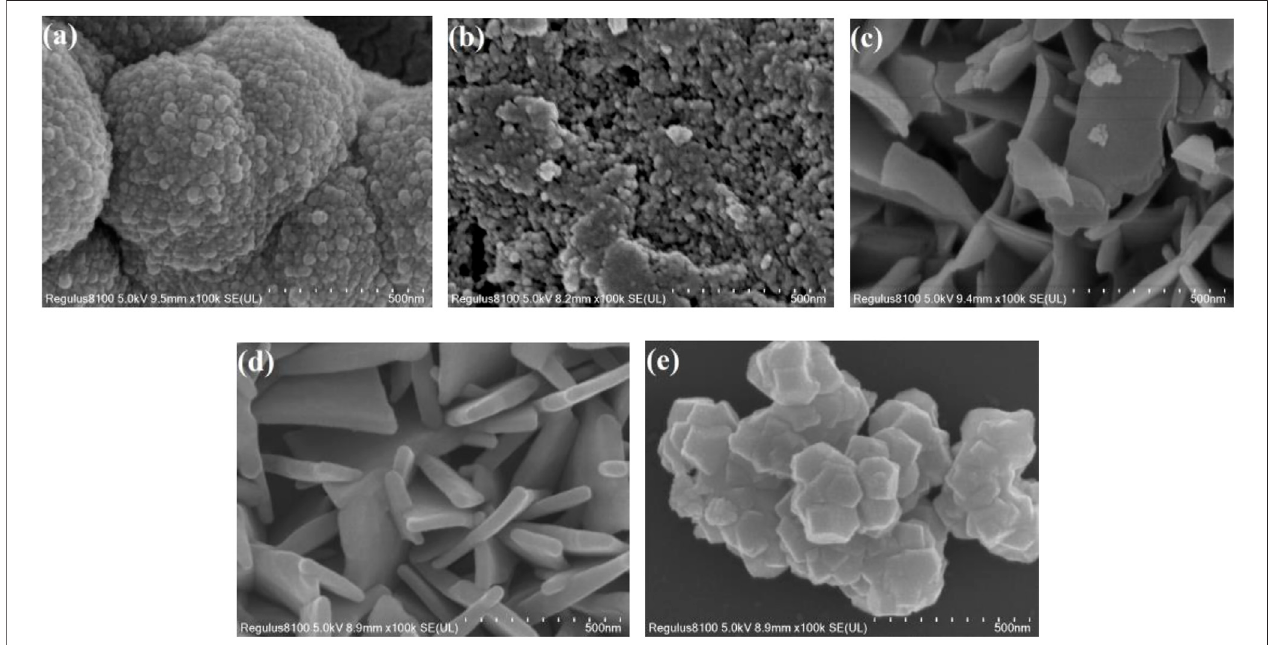
FIGURE 3 | SEM images of Zn-Zr MOF-1 (A) , Zn-Zr MOF-2 (B) , Zn-Zr MOF-3 (C) , Zn MOF (D) , and Zr MOF (E)